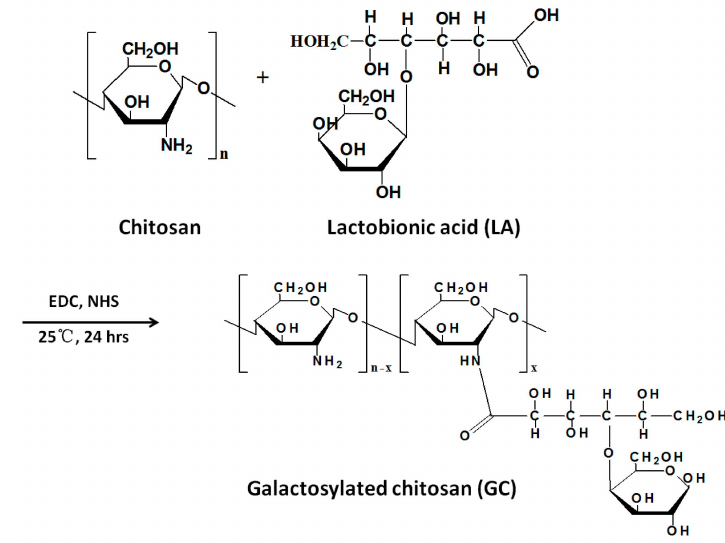
Figure 12. Preparation of galactosylated chitosan (GC).